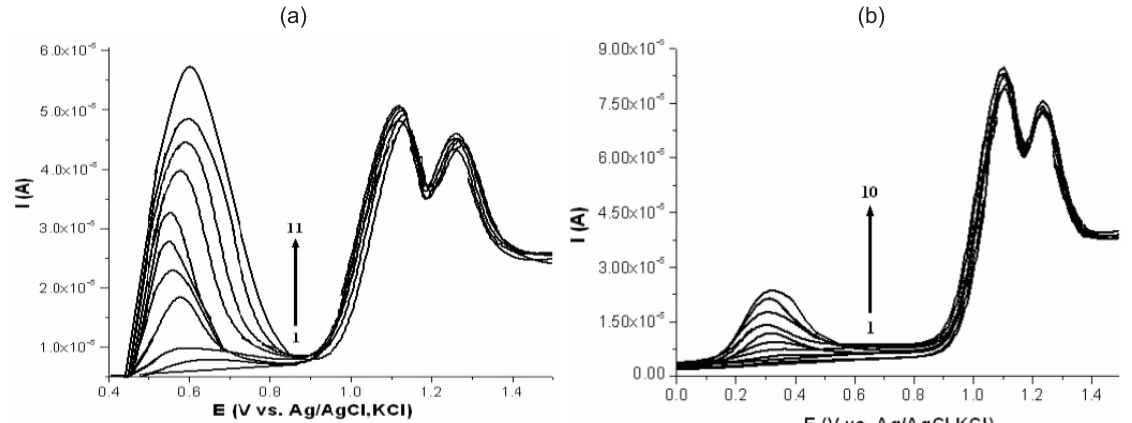
Figure 8. Differential pulse voltammograms on electrochemically activated glassy carbon electrode for (a) a 10 -3 mol L -1 codeine phosphate solution in the presence of different paracetamol concentrations: (1) 0, (2) 10 -6 , (3) 5×10 -6 , (4) 10 -5 , (5) 5×10 -5 , (6) 7.5×10 -5 , (7) 10 -4 ,